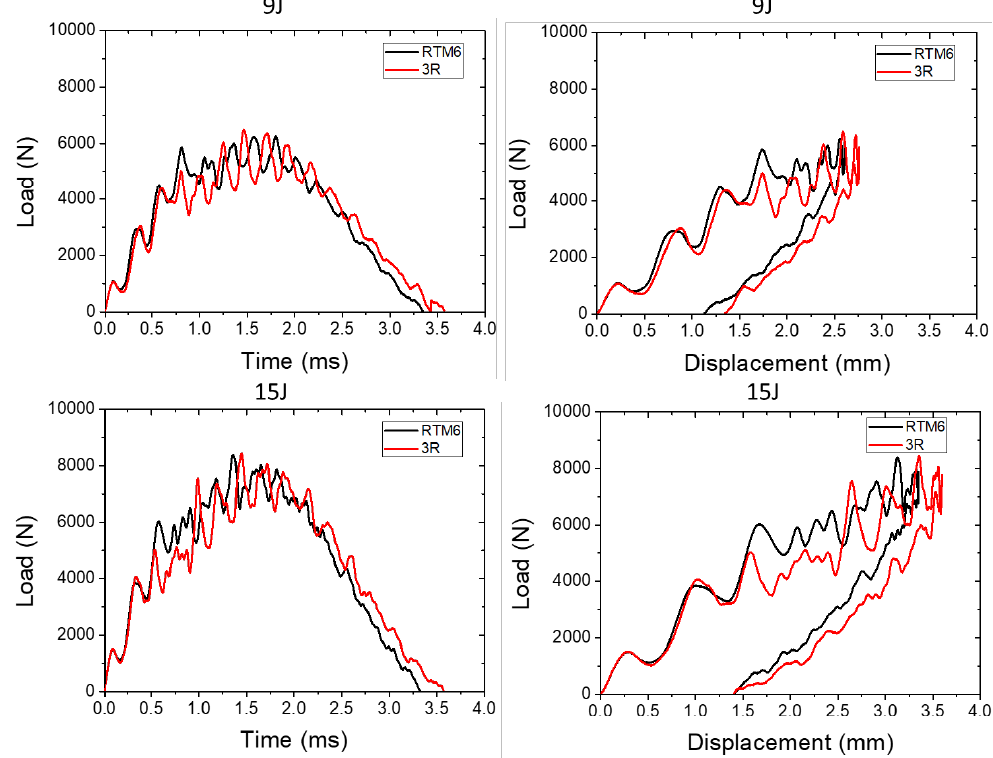
Figure 8. Representative load/time and load/displacement plots of impacts at 9 J and 15 J of conventional and 3R specimens. Table 1. Knockdown effect values of 9 and 15 J impacts.